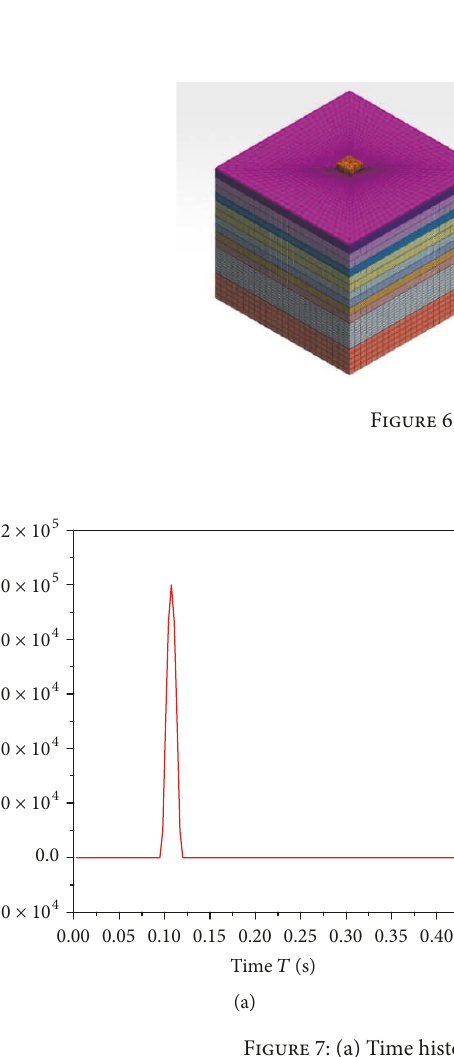
Figure 5: (a) Dynamic stiffness and (b) normalized dynamic stiffness change with effective friction area.